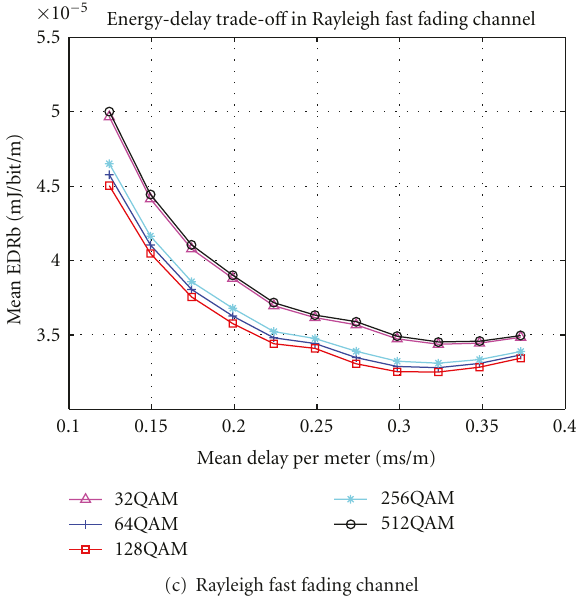
Figure 7: E ff ect of modulation on energy-delay tradeo ff in di ff erent